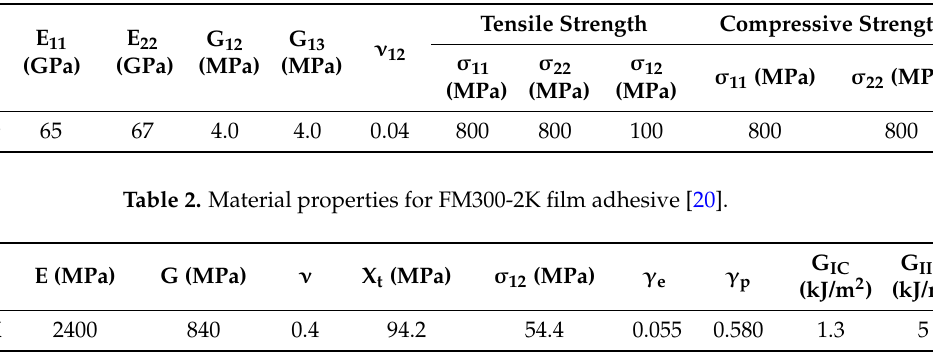
Table 2. Material properties for FM300-2K film adhesive [20].